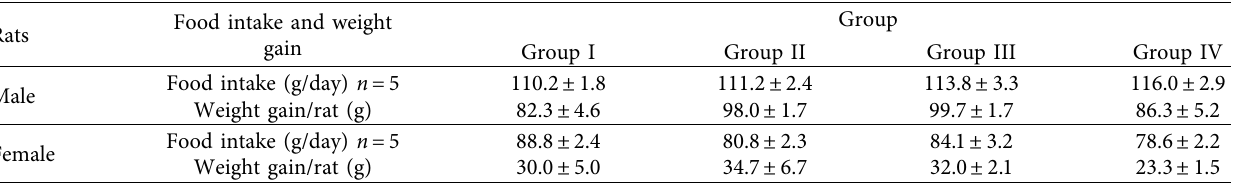
Figure 1: Pictures showing the normal liver (a), kidney (b), and brain (c) of rat treated with 1000mg/kg body weight of R. prinoides extract. Table 2: Food intake and weight gain of rats treated with leaf extract of R. prinoides .